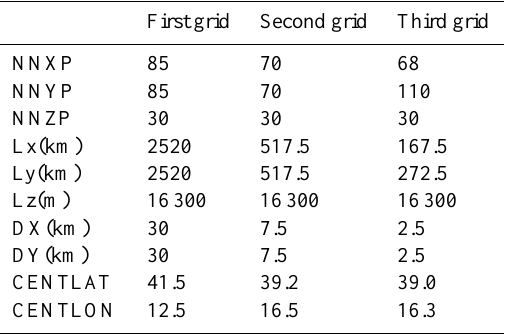
Table 1. RAMS model setting. NNXP, NNYP and NNYZ are the number of grid points in the west-east, north-south, and vertical directions. Lx(km), Ly(km), Lz(m) are the domain extension in the west-east, north-south, and vertical directions. DX(km) and DY(km) are the horizontal grid resolutions in the west-east and north-south directions. CENTLON and CENTLAT are the geo- graphical coordinates of the grid centres. First grid